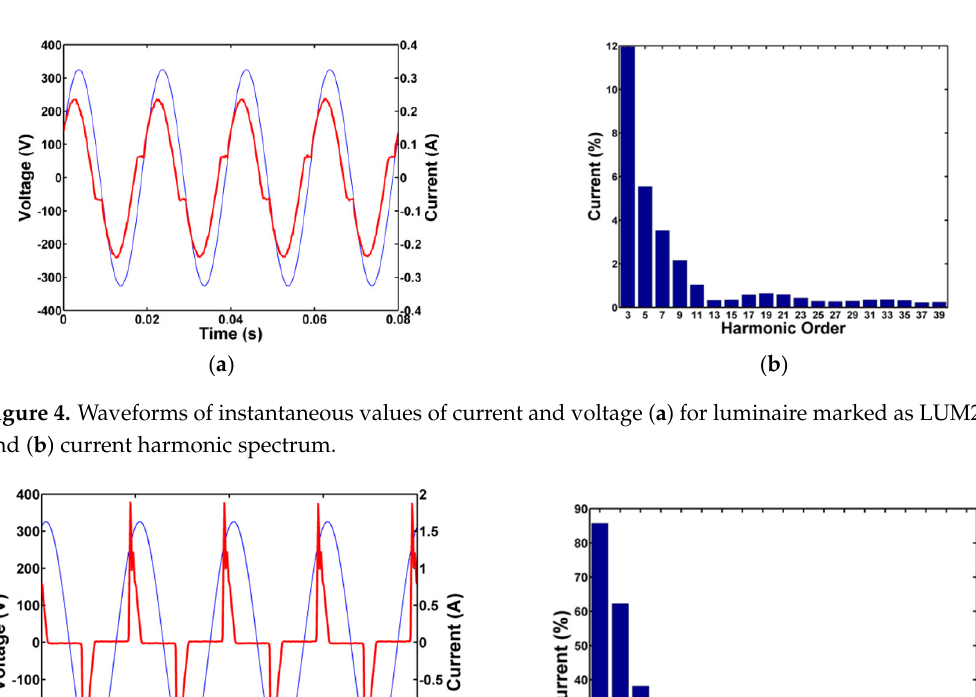
Figure 3. Waveforms of instantaneous values of current and voltage ( a ) for luminaire marked as LUM1 and ( b ) current harmonic spectrum.